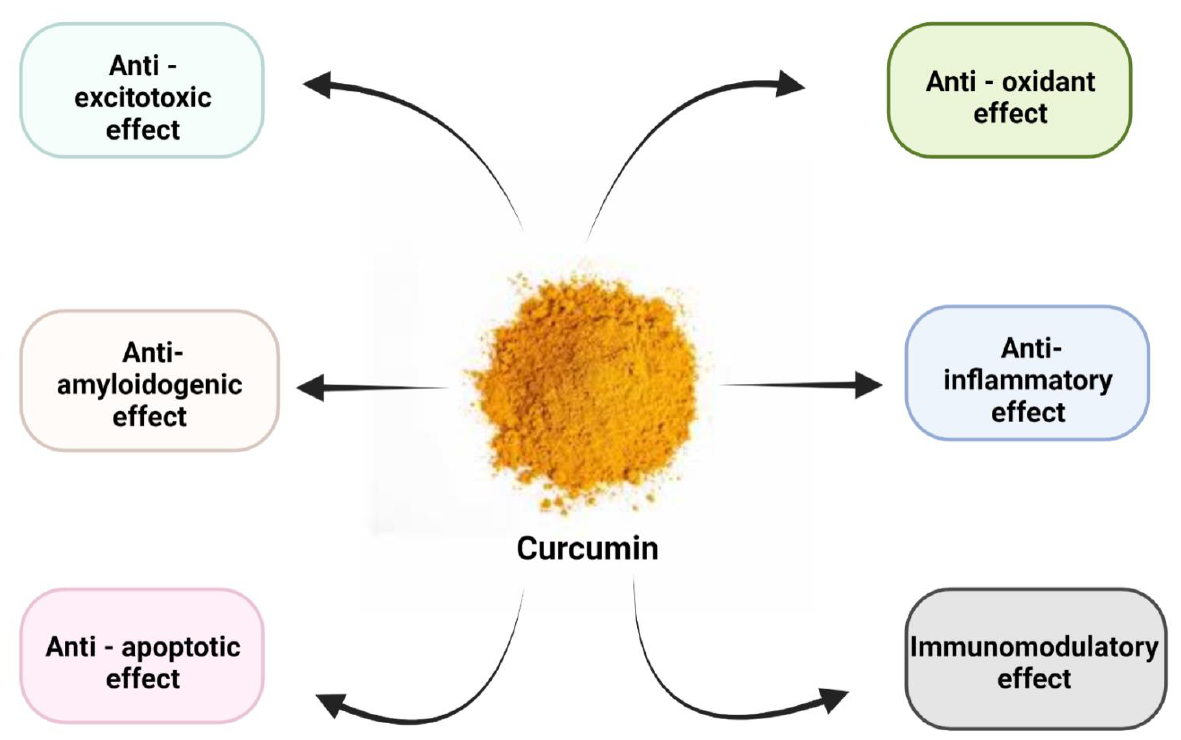
Figure 2. Pharmacological effects of curcumin.